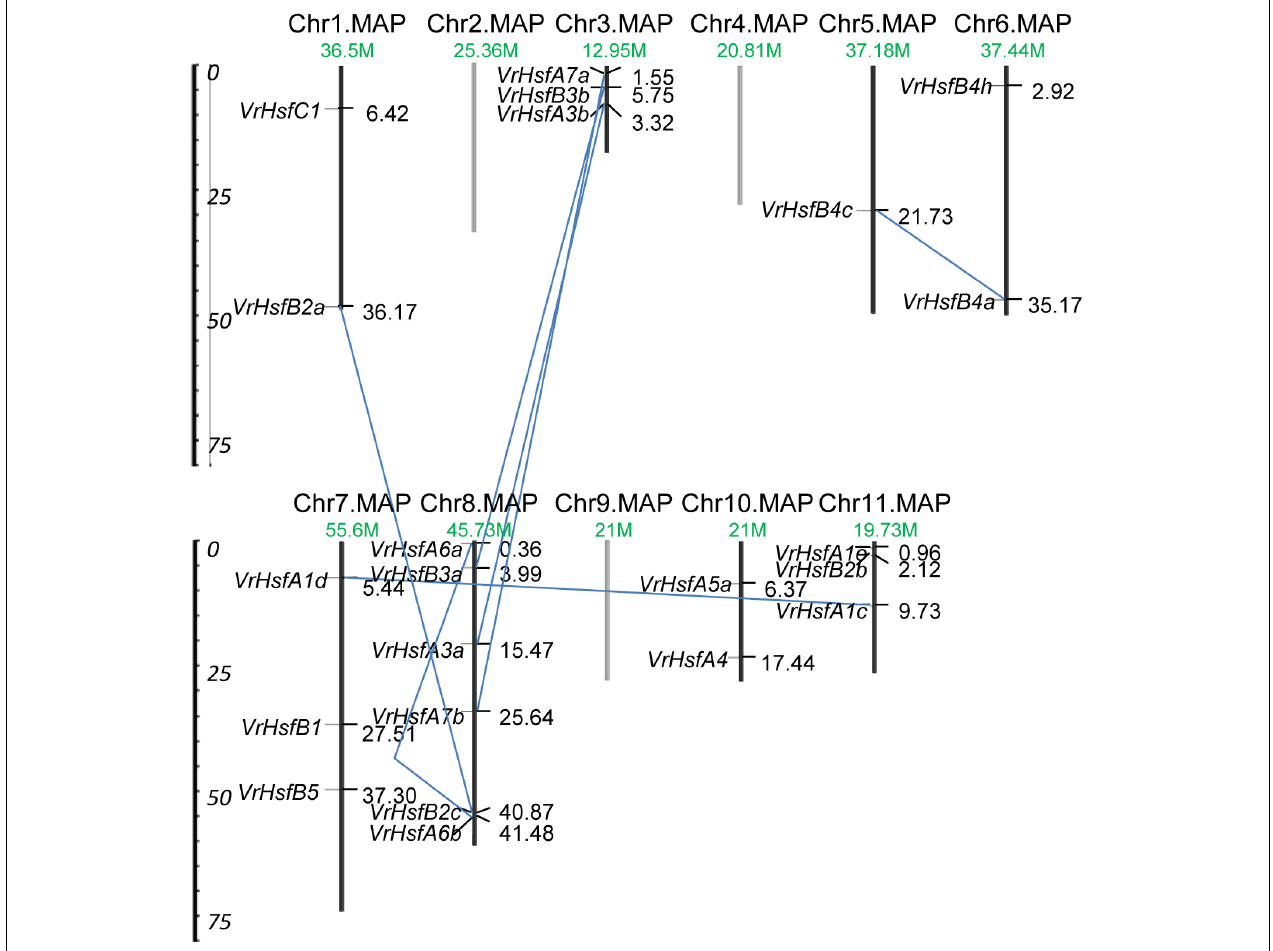
FIGURE 4 | Chromosomal location and duplication analysis of VrHsf genes. Chromosome number and length are represented. The positions for each VrHsf gene are shown on the chromosome. The blue lines indicate segmental